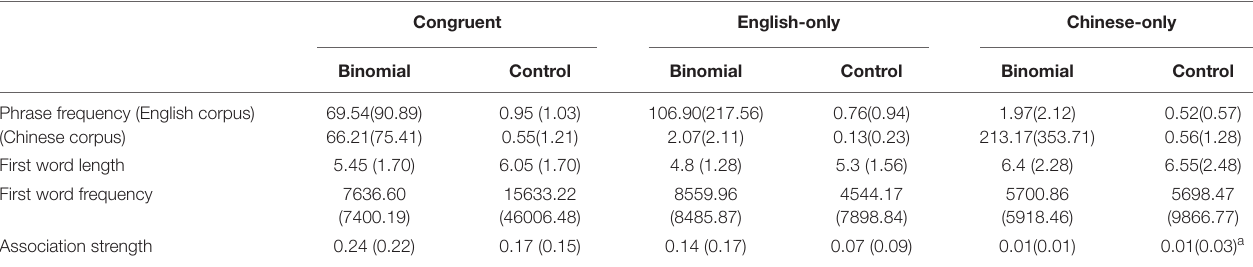
TABLE 3 | Means (standard deviations) of phrase frequency, word length and frequency of first word, and semantic association strength for the binomial and control conditions (counts based on occurrences per 100 million